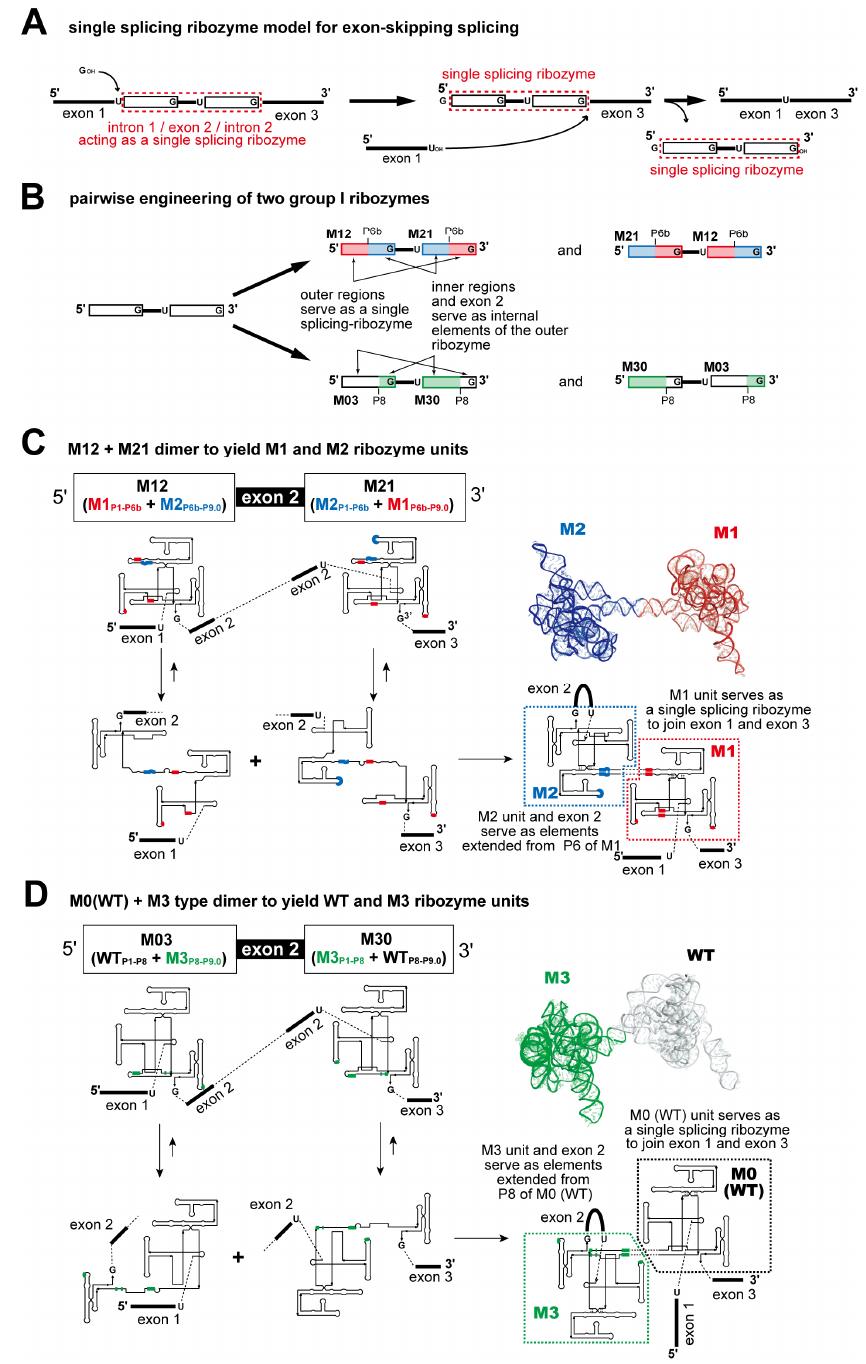
Figure 3. Rational engineering of tandemly aligned introns to induce exon-skipping splicing. ( A ) Schematic representation of a single splicing ribozyme model for exon-skipping splicing. Intron 1, exon 2, and intron 2 enclosed with red broken lines act as a single splicing ribozyme. ( B ) Pairwise engineering of two group I introns to eliminate their splicing activities. Two introns were engineered to form an active ribozyme to cooperatively join exon 1 and exon 3. ( C ) Secondary and 3D structures of a pair of chimeric introns (M12 + M21). In 3D structures, active ribozymes organized by the pairing of two chimeric introns are shown in blue (M1) and red (M2). ( D ) Secondary and 3D structures of a pair of chimeric introns (M03 + M30). In 3D structures, active ribozymes organized by the pairing of two chimeric introns are shown in green (M3) and gray